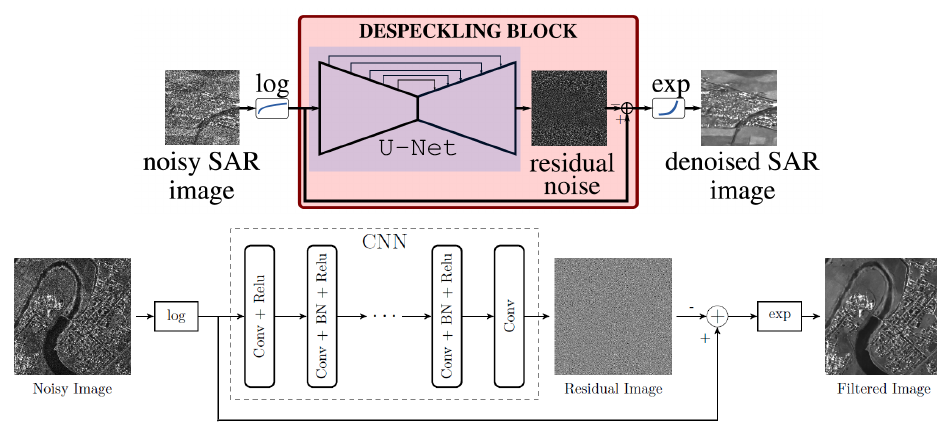
Figure 14. ( Up ) U-Net [221]. ( Down ) ResNet